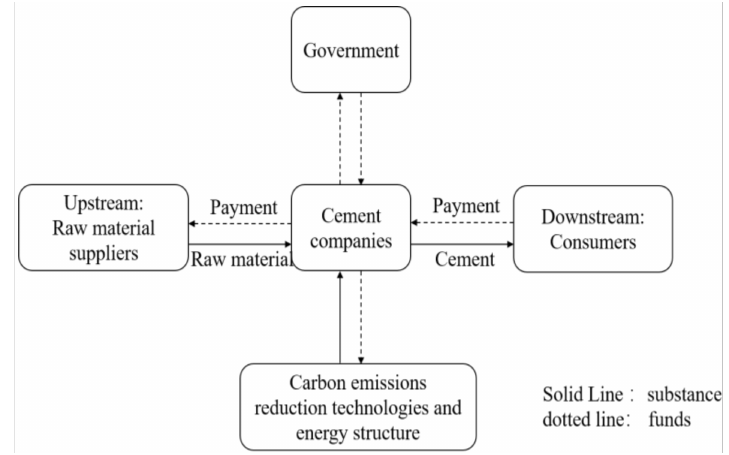
Figure 1. Logistics and capital flow of the cement company.